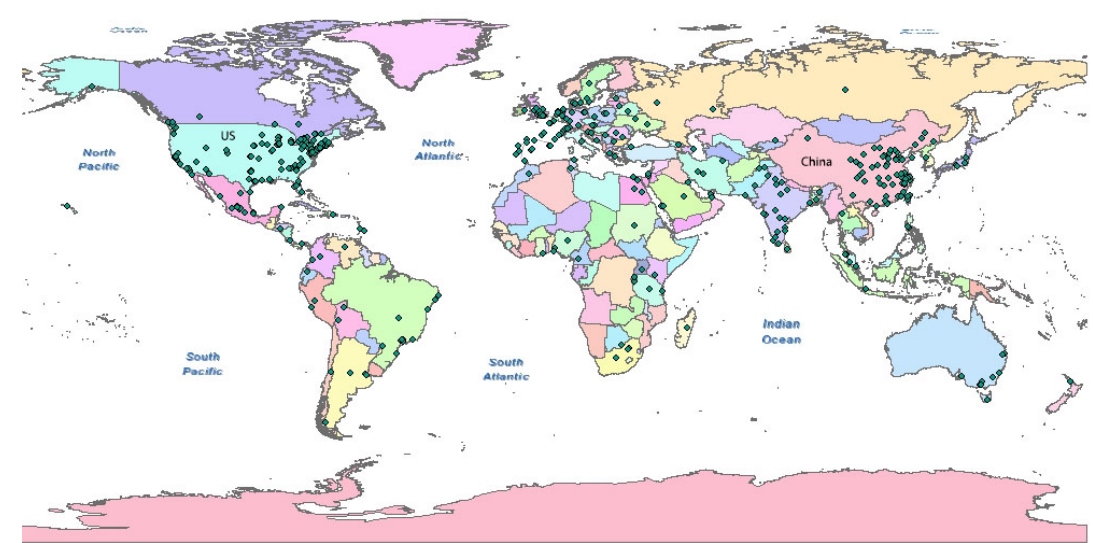
Figure 1. Location of the participants.